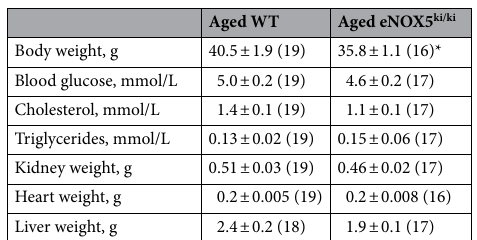
Table 1. Metabolic parameters in aged WT and eNOX5 ki/ki mice. Data are shown as mean ± SEM (n). P < 0.05 * compared with aged